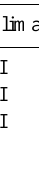
Set of ORCHIDEE-WET simulations. Performed ORCHIDEE-WET simulations are defined by climate, atmospheric CO 2 and CH 4 concentration values used as forcing. For each forc- ing, pre-industrial values (PI) or transient following SRES-A2 sce- nario (T) can be